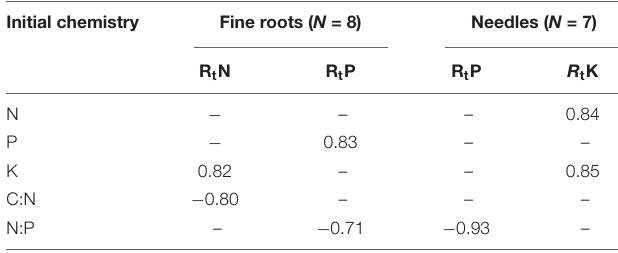
TABLE 6 | Pearson correlations ( p < 0.05) for the fine roots and needle litter initial chemistry, respectively, and nutrient release rates (R t ). Initial